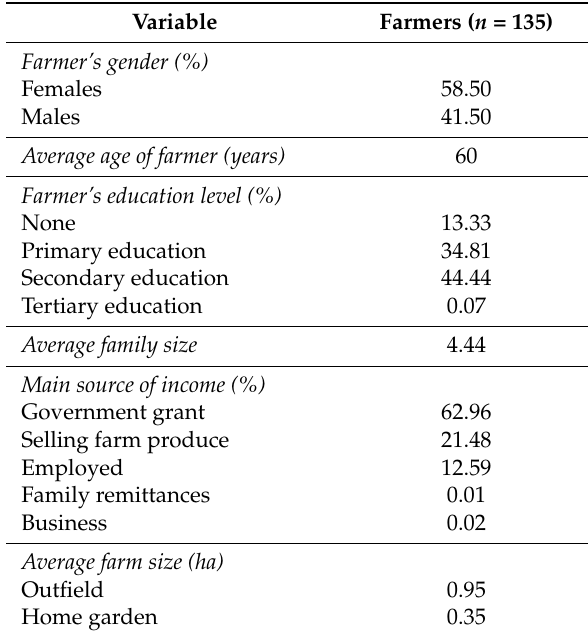
Table 2. Demographic and socio-economic characteristics of the sampled smallholder farmers in five purposely selected districts in the Eastern Cape